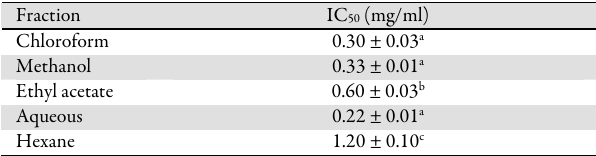
Table 3. IC 50 (mg/ml) of fractions of C.